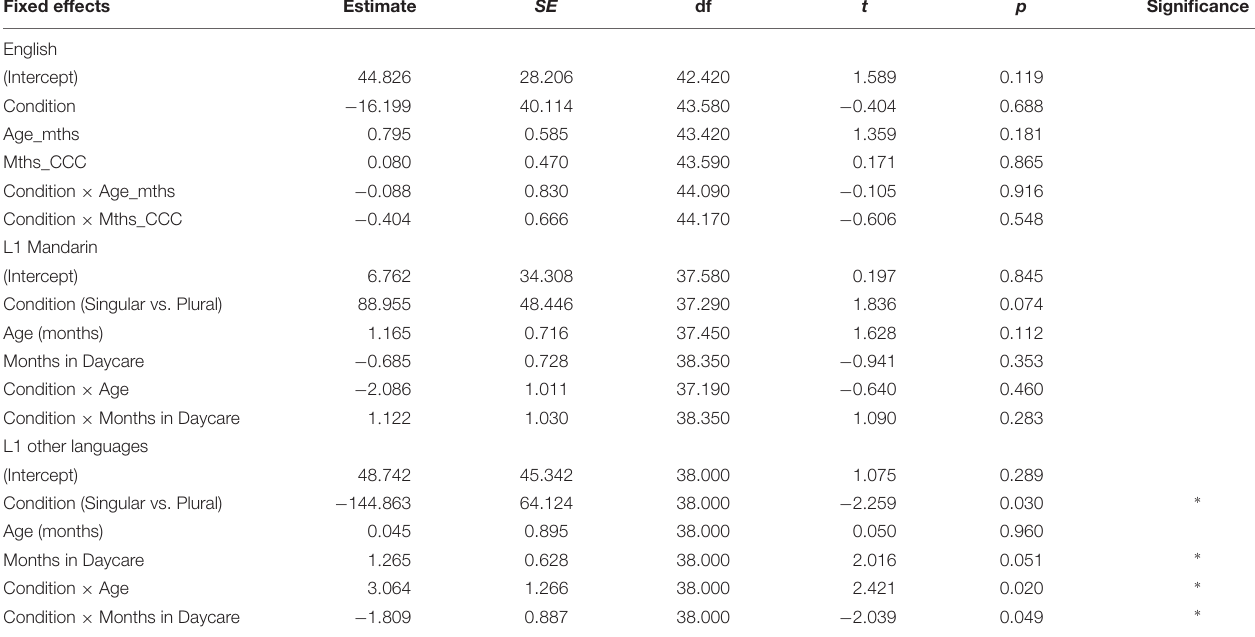
TABLE 5 | Main effects and interaction with estimated